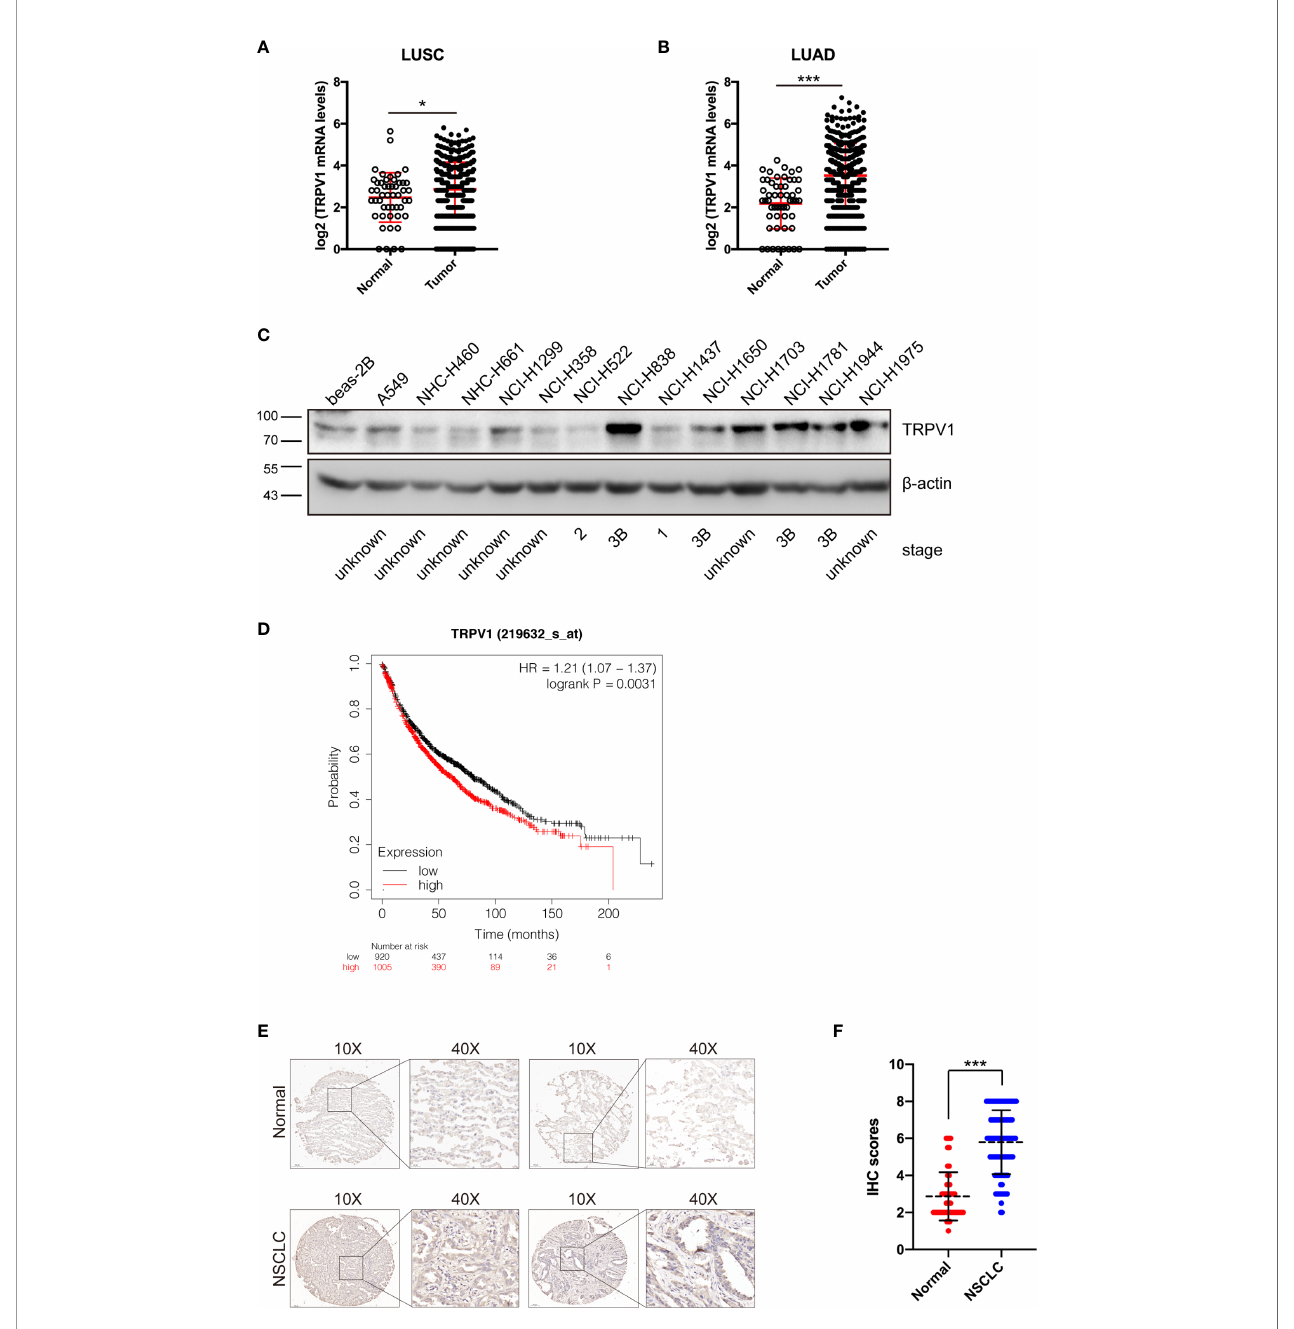
FIGURE 1 | TRPV1 expression is increased in non-small-cell lung cancer. (A) TRPV1 mRNA expression is increased in lung squamous carcinoma (LUSC) patients from TCGA database. Normal, n=49; Tumor, n=502. (B) The TRPV1 mRNA expression level is increased in lung adenocarcinoma (LUAD) patients from TCGA database. Normal, n=59; Tumor, n=535. (C) Immunoblotting analysis of TRPV1 protein expression in NSCLC cell lines; b -actin served as the loading control. (D) Kaplan – Meier plots of lung cancer patients with different TRPV1 mRNA expression (high versus low) in the KM-Plotter database (www.kmplot.com). (Analysis criteria: patients separated according to the follow-up threshold, all; optimal cutoff, auto select). (E) IHC staining showed the TRPV1 expression in NSCLC and normal lung tissues. Scale bar, 100 m m. (F) Statistical analysis of (E) . Three independent experiments were performed. Data represent mean ± SD; * P < 0.05. *** P <